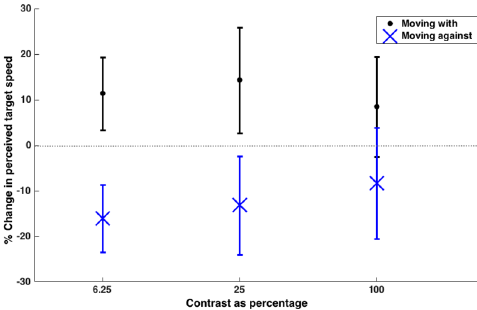
Fig 6. Mean ( ± SD) percentage change in perceived speed for Experiment 5 (N = 15 participants). All manipulations of the level of contrast in the texture produced a change in perceived speed that was significantly different from